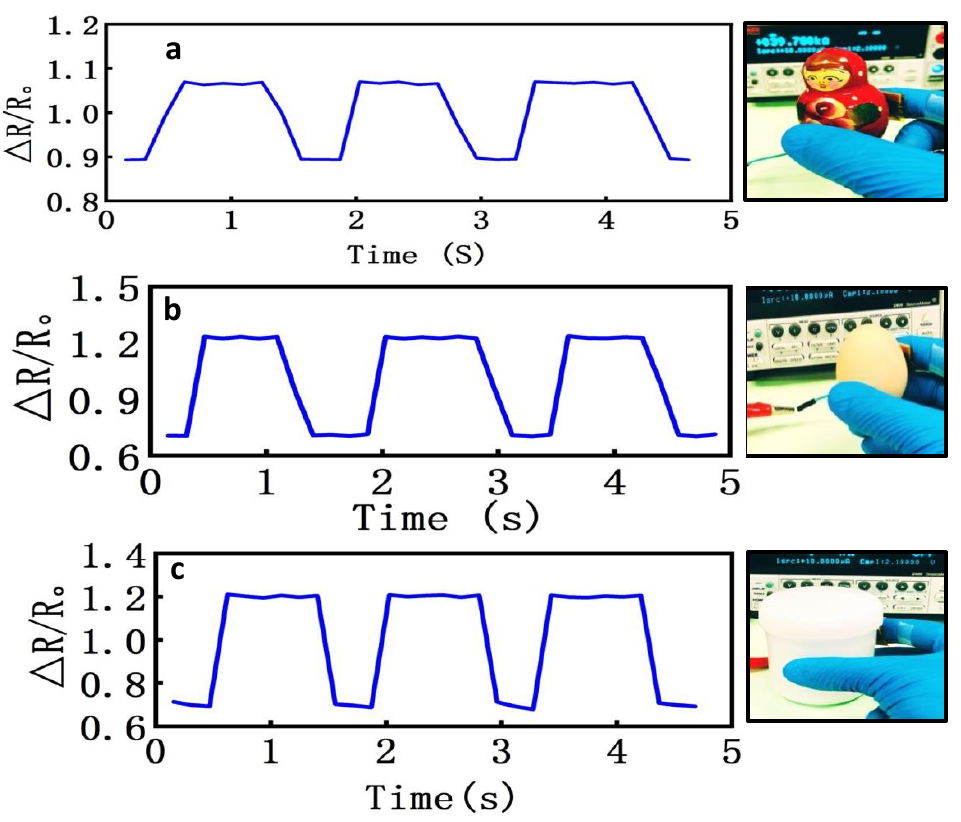
Figure 8. Relative resistance change monitored by the sensor attached to the fingertip when grasping a souvenir ( a ), egg ( b ), and cup ( c ) with different weights.